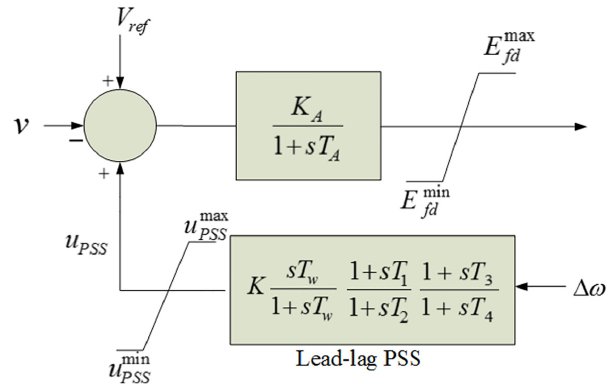
Fig 2. Power system stabilizer with the IEEE type-ST1 excitation